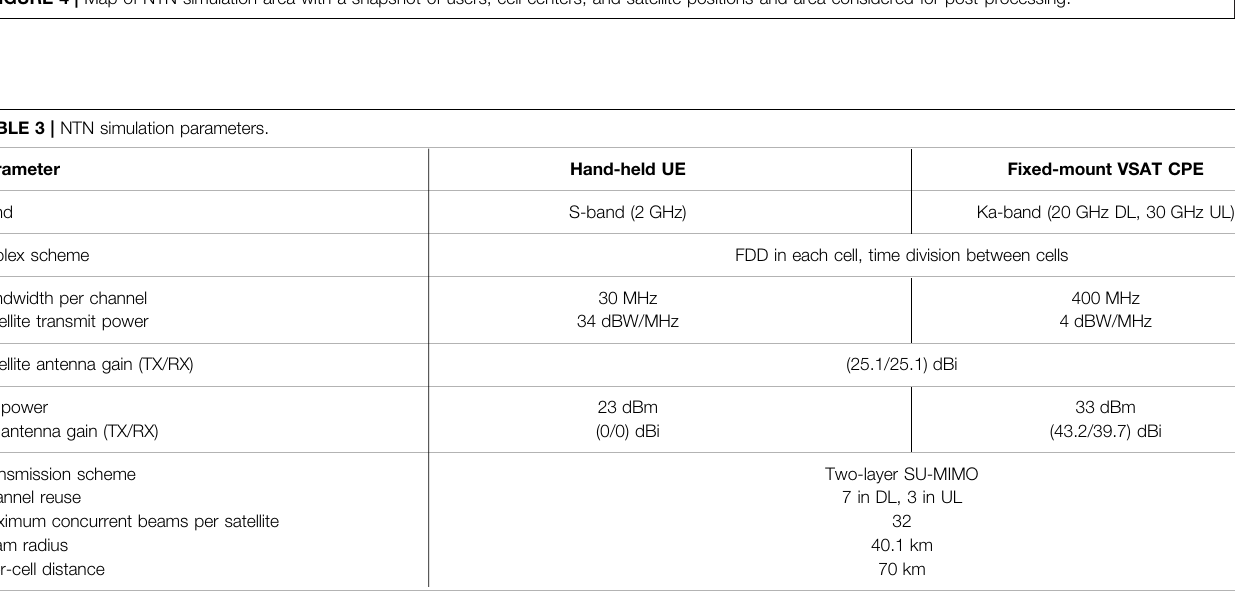
FIGURE 4 | Map of NTN simulation area with a snapshot of users, cell centers, and satellite positions and area considered for post-processing.